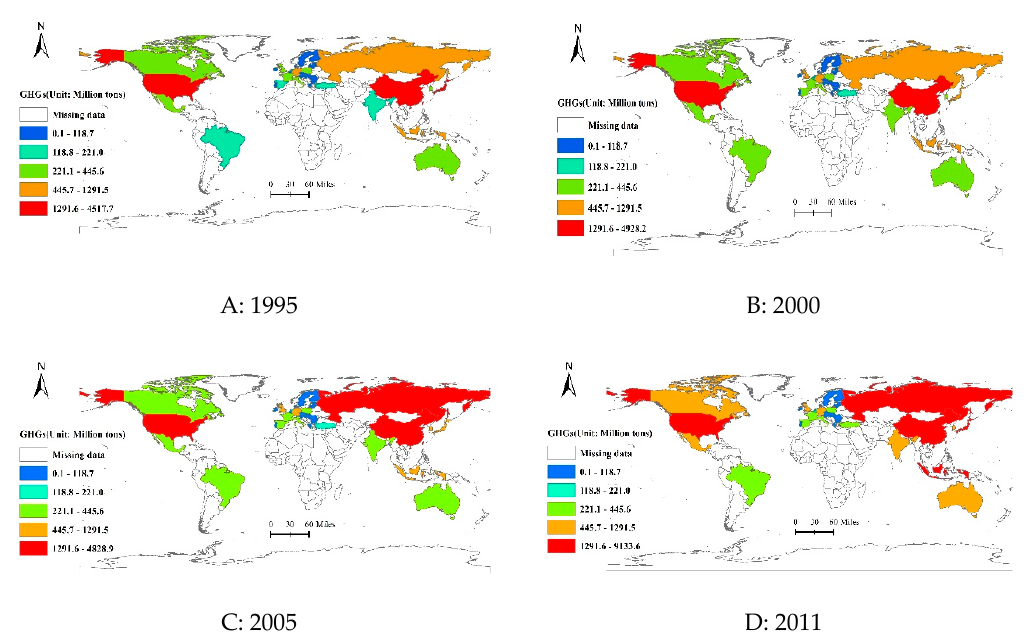
Figure 2. Spatiotemporal evolution characteristic of the total GHGs released by 39 major countries under a consumption-based accounting principle from 1995 to 2011.